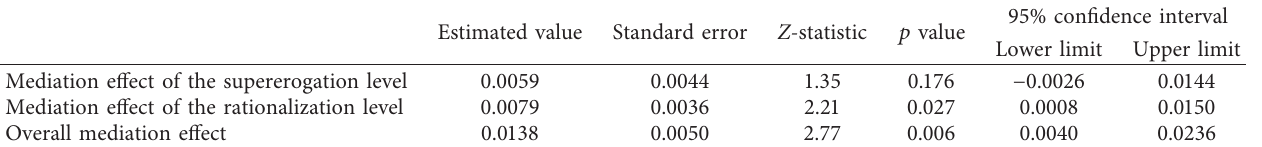
Table 10: Mediation robustness test results by using the Bootstrap